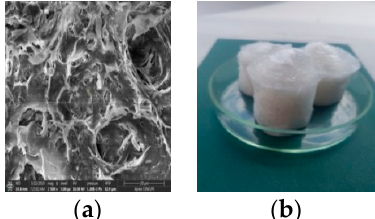
Figure 1. ( a ) SEM image of cellulose fiber coated with PEG-based monomers and ( b ) image of cellulose